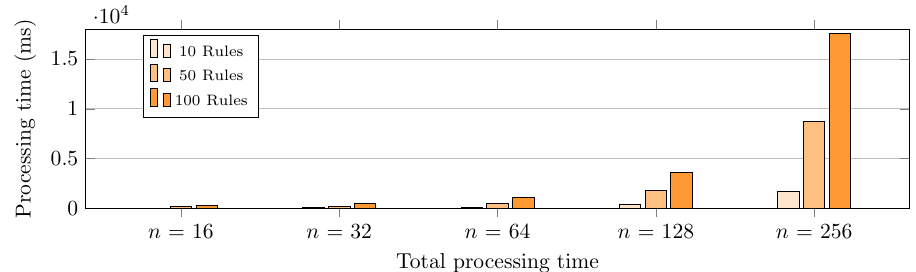
Figure 7. Graphical view of performance evaluation result (total processing